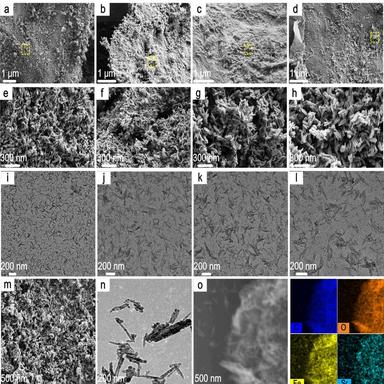
Different magnification SEM images of the (a, e) SrFe12O19 NR/G-42.3, (b, f) SrFe12O19 NR/G-36.1, (c, g) SrFe12O19 NR/G-29.7, (d, h) SrFe12O19 NR/G-22.4; TEM images of (i) SrFe12O19 NR/G-42.3, (j) SrFe12O19 NR/G-36.1, (k) SrFe12O19 NR/G-29.7, (l) SrFe12O19 NR/G-22.4; (m) SEM and (n) TEM image of the bare SrFe12O19; (o) EDS mappings of SrFe12O19 NR/G-29.7.